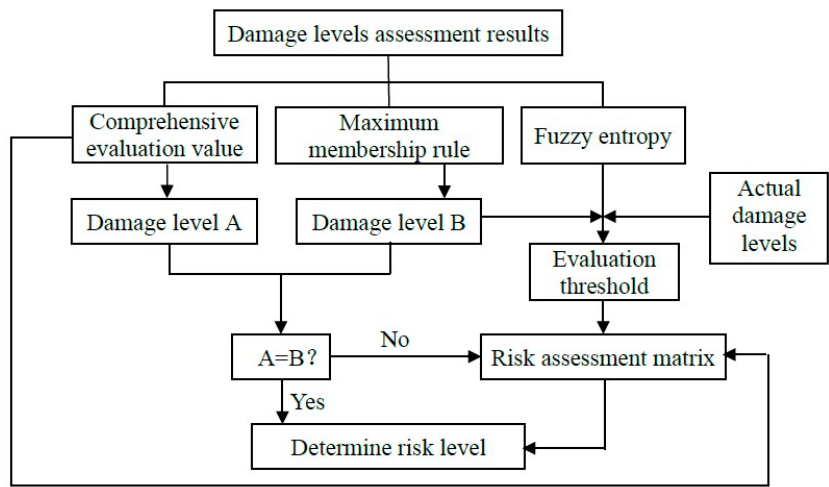
Figure 12. Risk assessment process of tunnel failure in the Ashele copper mine.